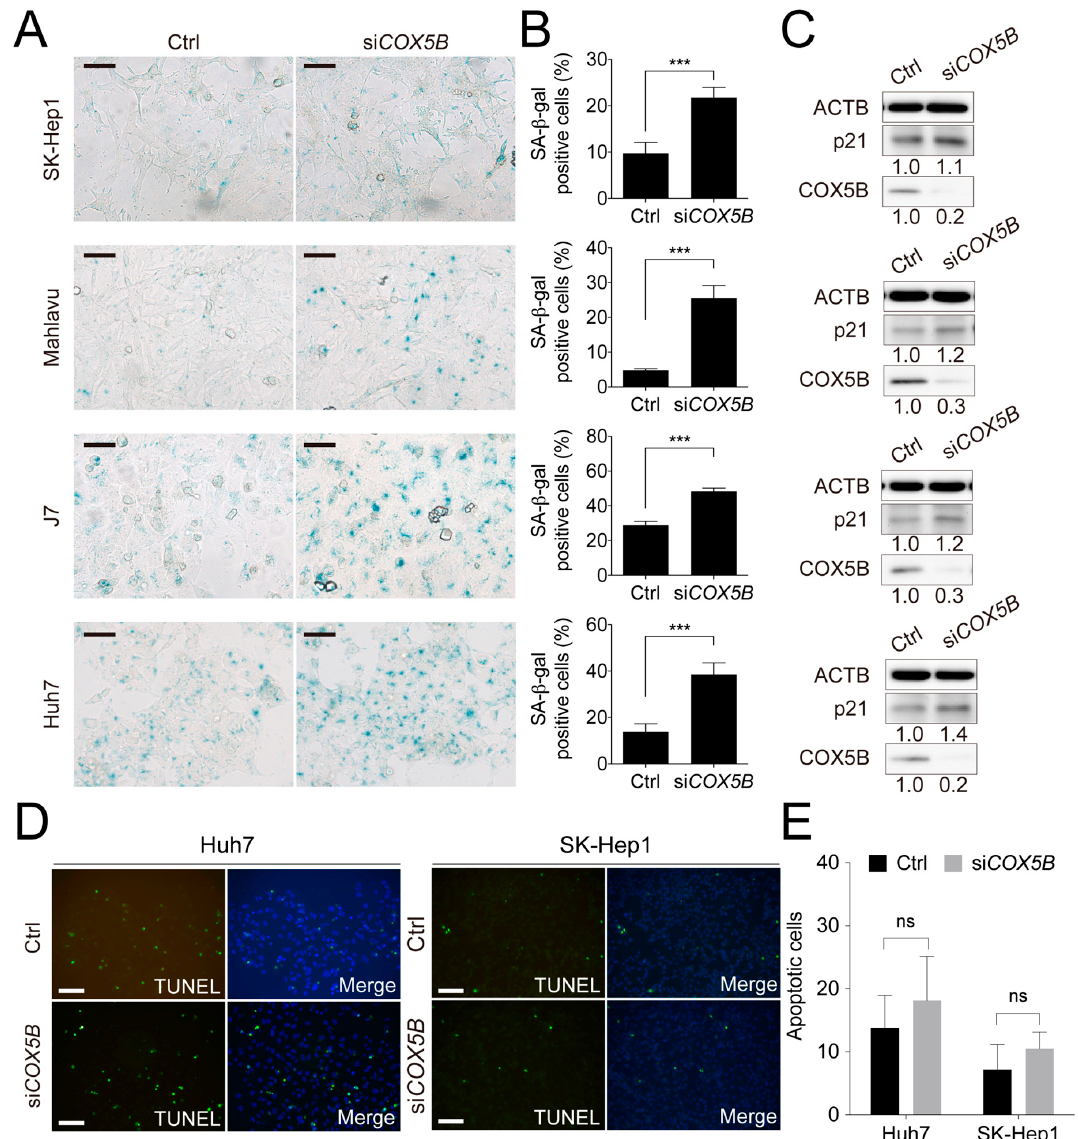
Figure 3. Knockdown of COX5B suppresses cell proliferation through induction of cell senescence but not programmed cell death. This figure was used to supplement Figure 2 in the main text. ( A ) The beta-galactosidase staining assay to examine the status of cell senescence. The black Scale bar represented 50 μ m. The quantitative results were shown in ( B ). ***, p < 0.001. ( C ) The western blot analysis of cell senescence marker p21 levels in HCC cells with or without depletion of COX5B. The western blot images in this panel were all acquired by using chemStudio PULS imaging system. ( D ) The TUNEL assay to determine the status of cell apoptosis. The white scale bar represented 50 μ m. The quantitative results were shown in ( E ). All the in vitro cell-based assays shown in this figure were conducted in duplicates.